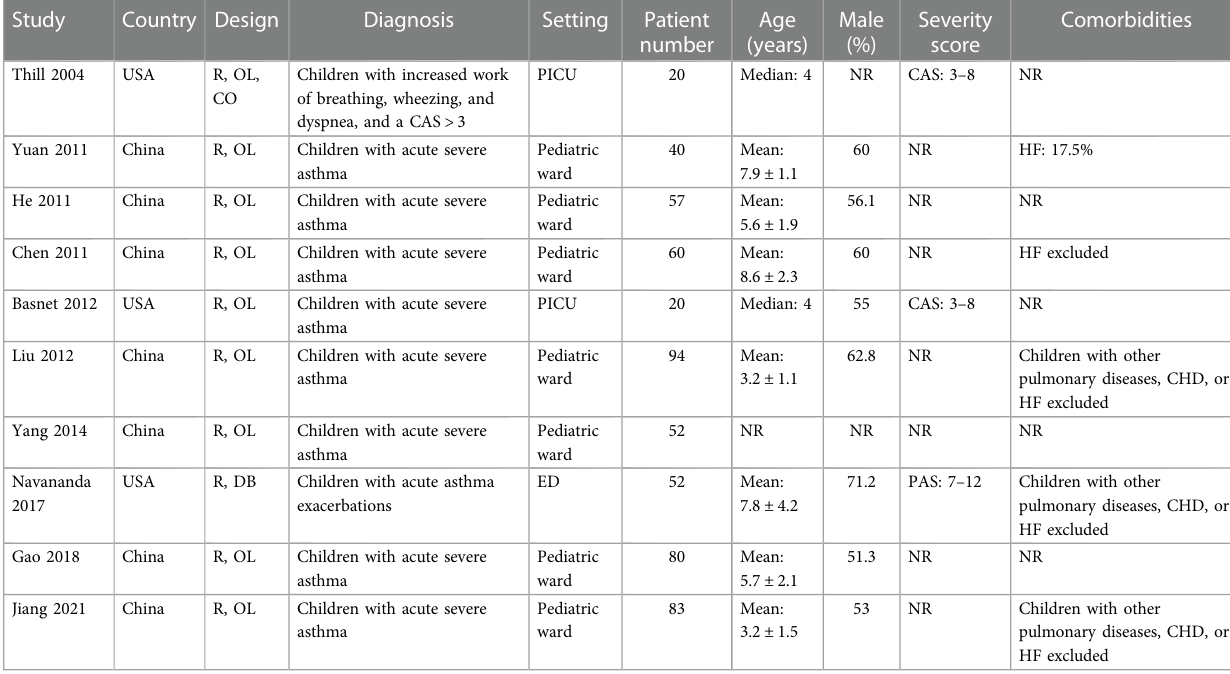
TABLE 1 Characteristics of the included patients.